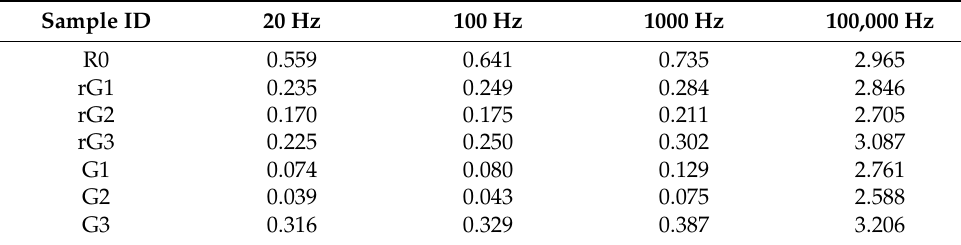
Figure 18. Electrical conductivity of the samples with GO and rGO: ( a ) 20 Hz; ( b ) 100 Hz; ( c ) 1000 Hz; ( d ) 100,000 Hz. Table 7. Electrical conductivity of the samples at specific frequencies (S/mm, × 10 − 3